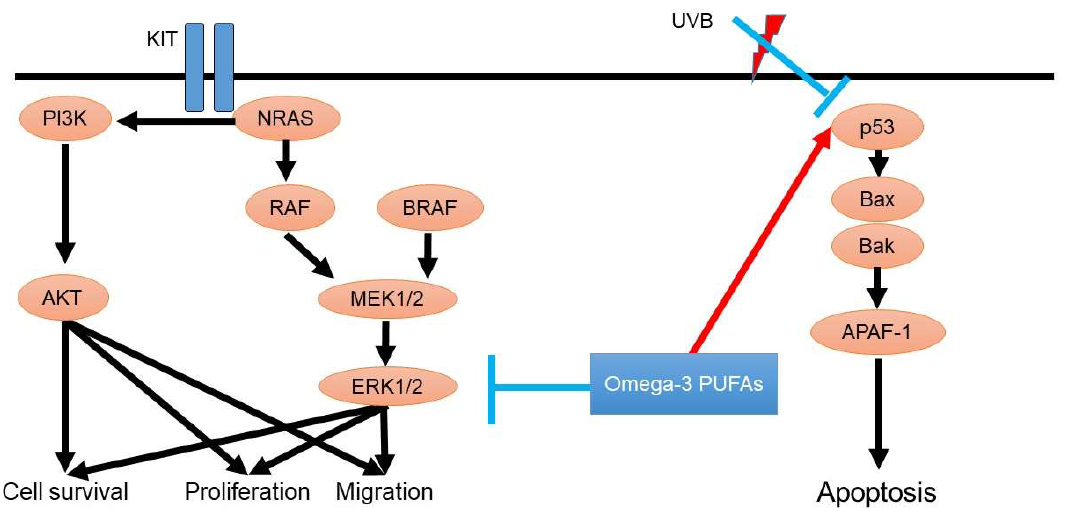
Figure 1. Oncogenesis signaling of malignant melanoma and possible roles of omega-3 PUFAs. BRAF plays a role in MAPK pathway activation, which regulates the development of tumor cells, such as apoptosis, cell growth, and proliferation. NRAS mutations are related to the regulation of PI3K. Ultraviolet light exposure dysregulates p53 expression, leading to the suppression of tumor cell apoptosis.